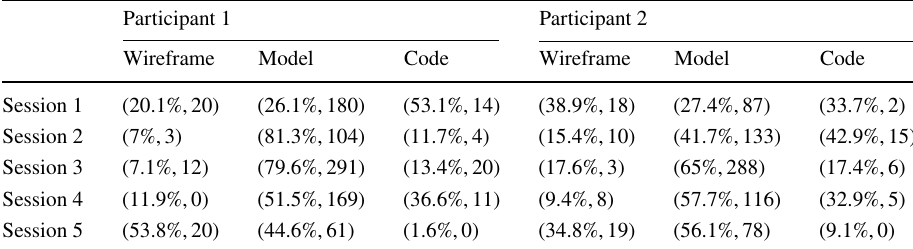
Table 1 Results of the activity evaluation for each session and